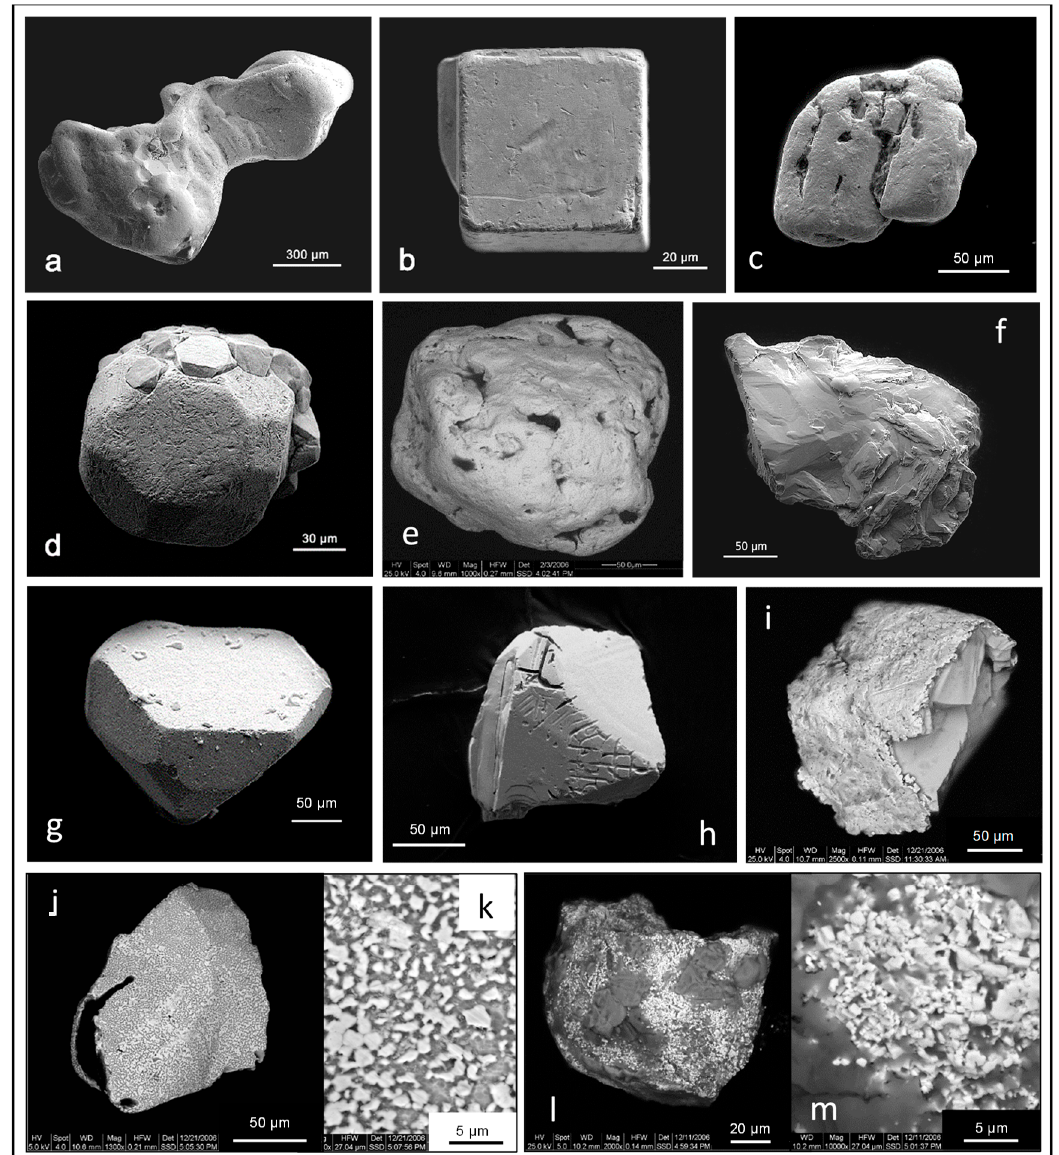
Figure 5. Detrital PGM, scanning electron microscope (SEM) images. ( a ) Pt–Fe alloy grain (1.6 mm in diameter) with smooth surface. Moopetsi river, Maandagshoek, eastern Bushveld. ( b ) Idiomorphic Pt–Fe alloy grain. Note slightly contorted edges. Locality as Figure 5a. ( c ) Well-rounded grain of Pt–Fe alloy. Makwiro river near Hartley Mine, Great Dyke, Zimbabwe. ( d ) Grain of Pt–Fe alloy with cubic crystal faces and smooth surface polish, intergrown with platelets of laurite (on top). Locality as Figure 5a. ( e ) Well-rounded grain of native Pt. Dithokeng river, northern Bushveld. ( f ) Splinter of large grain of cooperite. Locality as Figure 5a. ( g ) Sperrylite crystal showing little attrition. Locality as Figure 5a. ( h ) Well crystallized sperrylite grain with crystallographically oriented etch pits. Makwiro River, Hartley Mine. ( i ) Sperrylite with a thin surface coating of native platinum. Dwars river, eastern Bushveld. ( j , k ) Sperrylite surface overgrown by platelets of native platinum, ( k ) is surface magnification. Der Brocken, eastern Bushveld. ( l , m ) Tiny crystals of native Pt (light grey) on grain of pentlandite (dark grey). ( m ) Magnification from ( l ) showing crystals of native Pt (light grey). Brakspruit, western Bushveld.